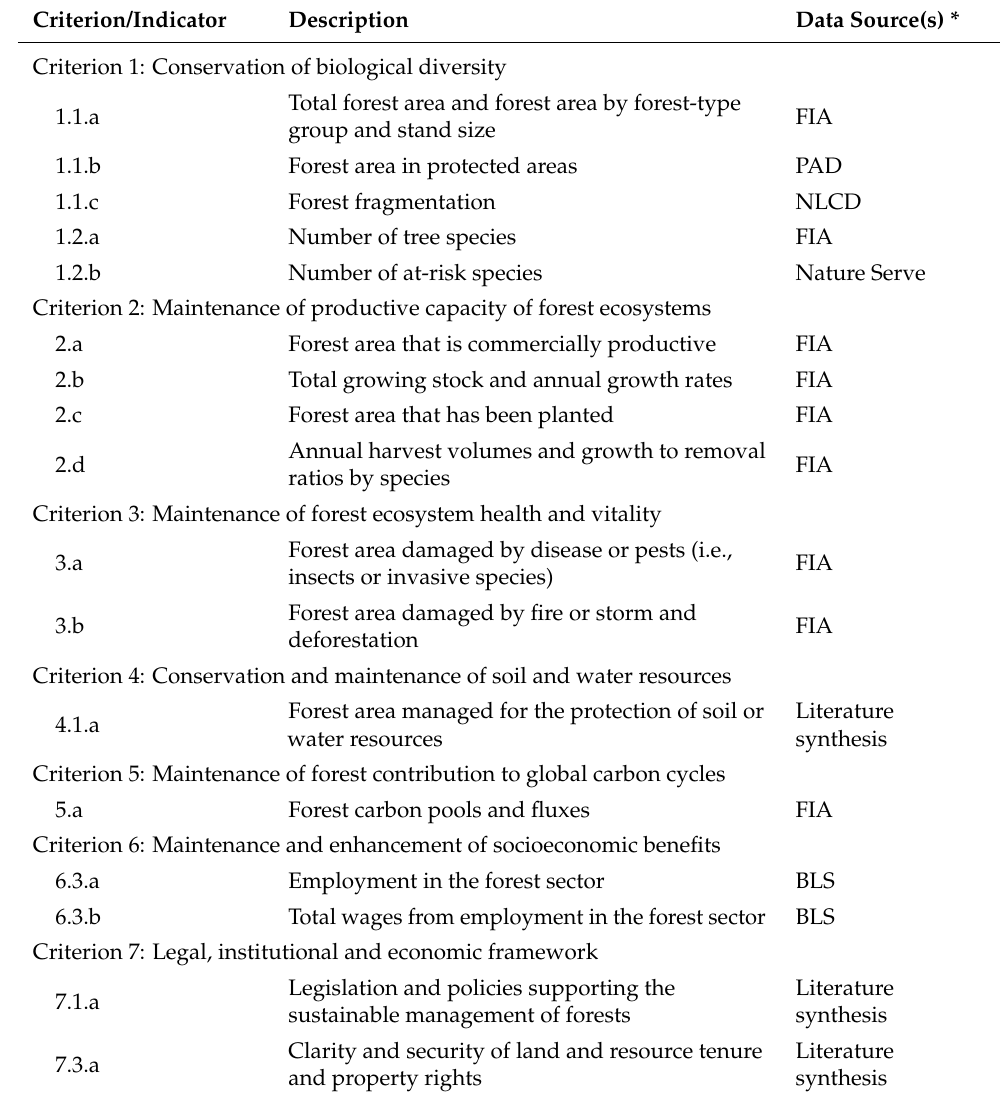
* BLS: Bureau of Labor Statistics; FIA: USDA Forest Service, Forest Inventory and Analysis plot-based inventory data; PAD: Protected Areas Database; NatureServe: NatureServe Map of Biodiversity Importance; NLCD: National Land Cover